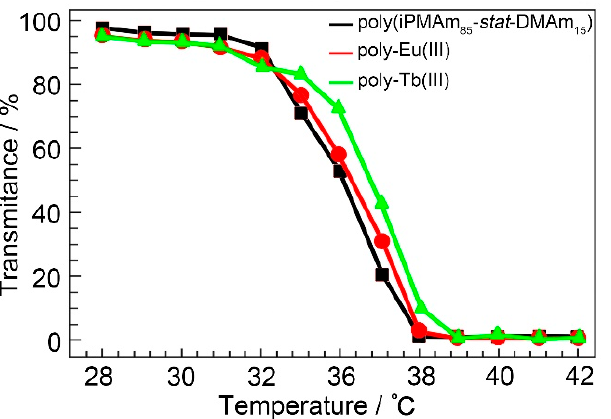
Figure 7. Transmittance–temperature of poly(iPMAm 85 - stat -DMAm 15 ), poly-Eu(III), and poly-Tb(III) (the aqueous polymer concentration, 1 wt.%). Table 2. A summary of cloud point ( T c ) and hydrodynamic radius ( R h ).